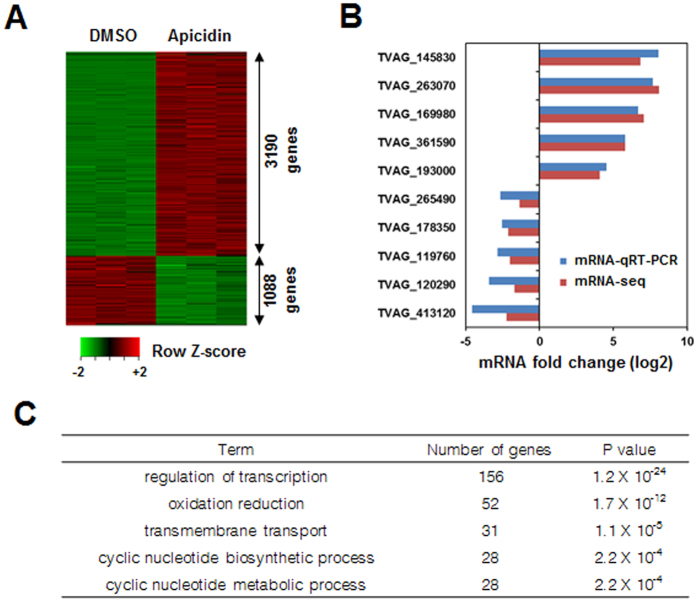
Global transcriptional responses of T. vaginalis to apicidin treatment.T. vaginalis cells were treated with DMSO (0.1%) or apicidin (70 nM) for 4 hours. RNA samples in each condition were collected and analyzed by RNA-seq. (A) Heat map representation of genes differentially expressed upon apicidin treatment. Only significantly changed genes (fold change >2, adjusted p-value < 0.05) are shown. (B) qRT-PCR was performed to validate the mRNA targets derived from RNA-seq. (C) Gene Ontology (GO) analyses of differentially expressed genes were performed to identify related biological functions.